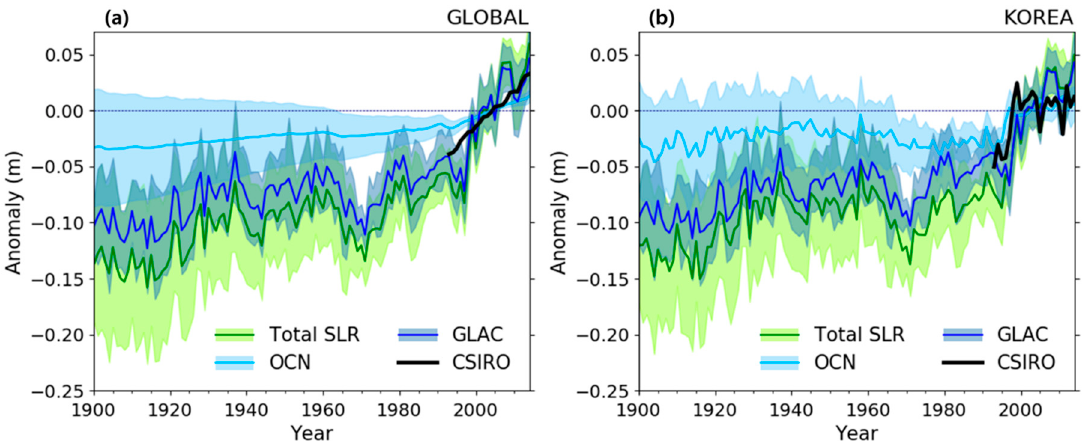
Figure 1. Spatial mean time series of simulated ocean thermal expansion (light blue) and glacier (blue) contributions to SLR from ensemble means of CMIP6 models for ( a ) global and ( b ) Korean Peninsula with 95% confidence intervals (shaded). Green and black lines indicate total SLR from CMIP6 models and observation, respectively. The reference is the mean climatology of the PD (1995–2014)